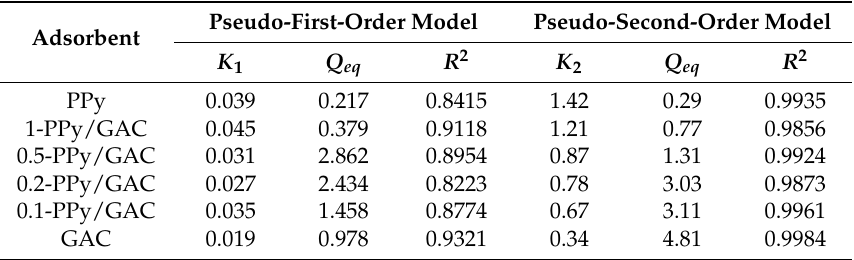
Table 3. Parameters for the pseudo-first-order and pseudo-second-order models.